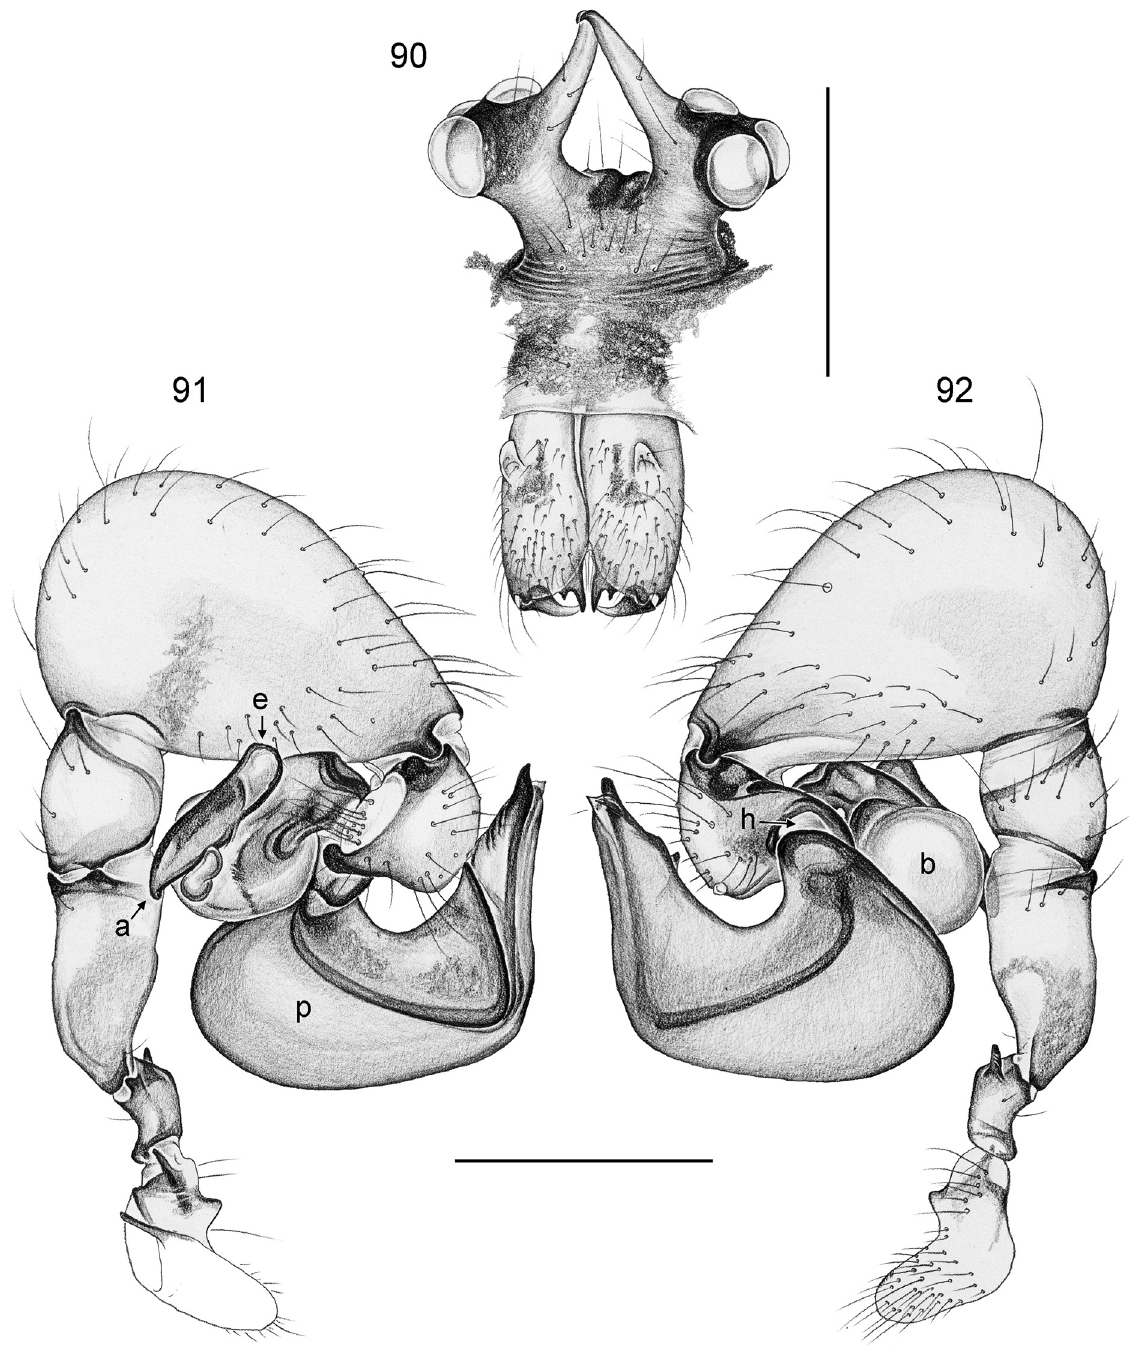
Figs 90–92. Panjange bukidnon Huber sp. nov. (ZFMK, Ar 13023). 90 . Male prosoma and chelicerae, frontal view. 91–92 . Left male palp, prolateral and retrolateral views. Abbreviations: a = appendix; b = genital bulb; e = embolus; h = hinge; p = procursus. Scale bars = 0.5